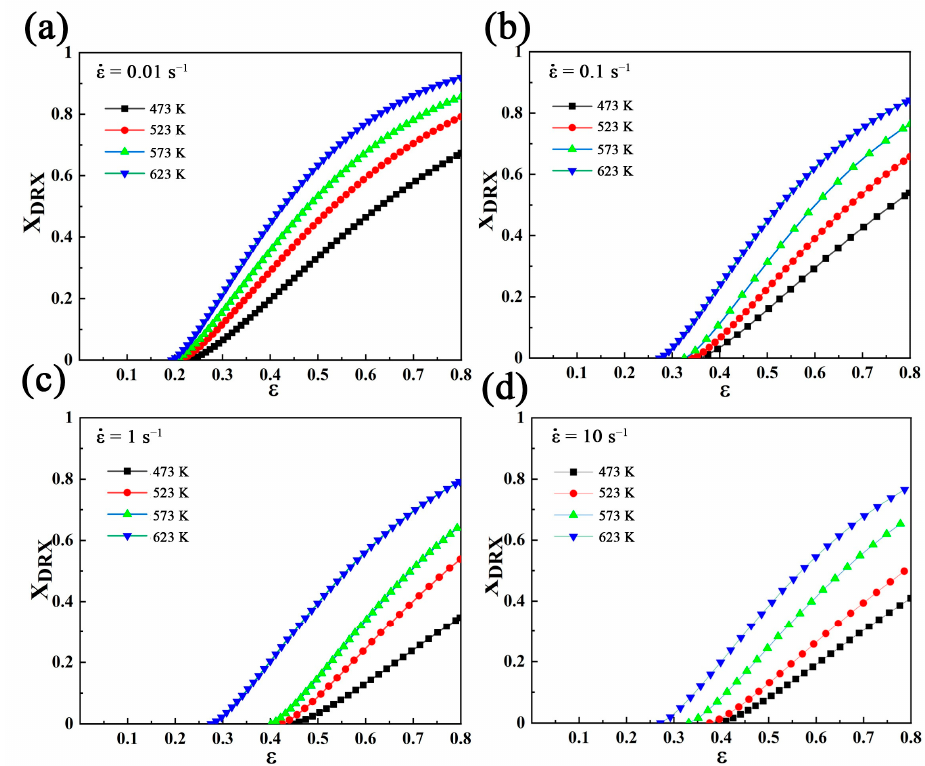
. . ε = 0.01 s − 1 ; ( b ) ε = 0.1 s − 1 ;